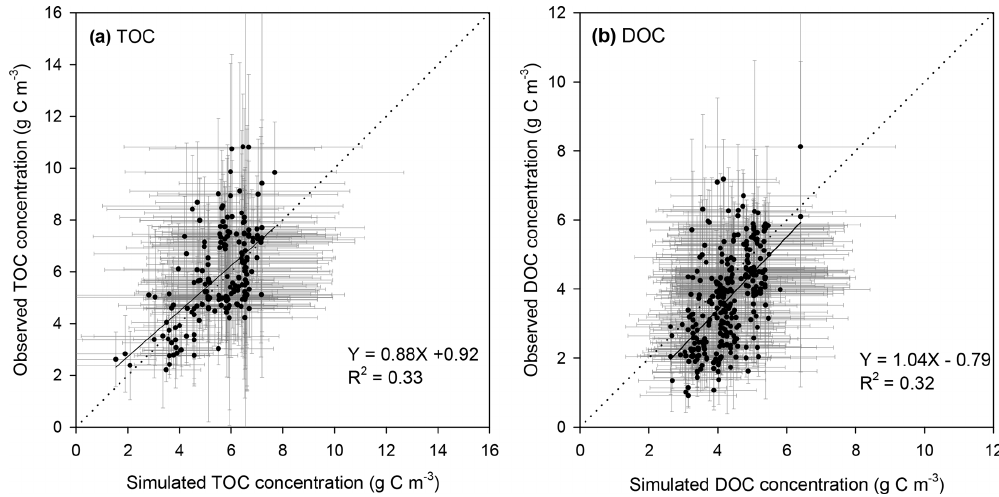
Figure 5. Comparison between the observed and simulated riverine TOC ( a , POC + DOC) and DOC (b) concentrations. The dot and error bar denote the mean and standard deviation at each gauging site, respectively. Note that the mean and standard deviation of the simulated concentrations at each site are calculated based on the monthly average value, but the mean and standard deviation of the observed concentrations are based on instantaneous observation.